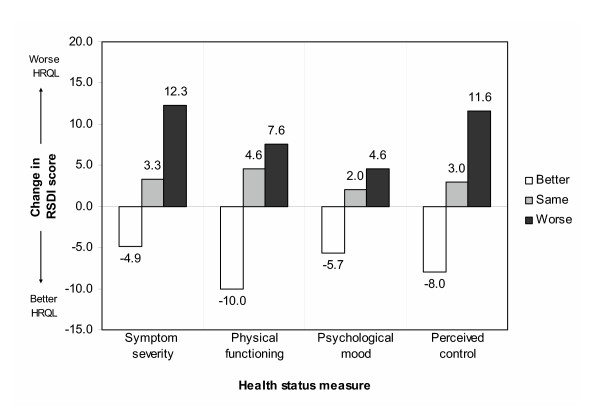
Responsiveness of RSDI to change in other health status measures. Bars represent mean change in RSDI score categorized by change in health status (better/same/worse, see legend above). A negative bars (decrease in RDSI) reflect better health-related quality of life (HRQL), whereas a positive bars (increase in RSDI) reflect worse HRQL. Symptom severity, physical functioning, psychological mood, and perceived control of rhinitis were assessed using the RSS-4, SF-12 PCS, CES-D, and PCRQ, respectively (see Methods).